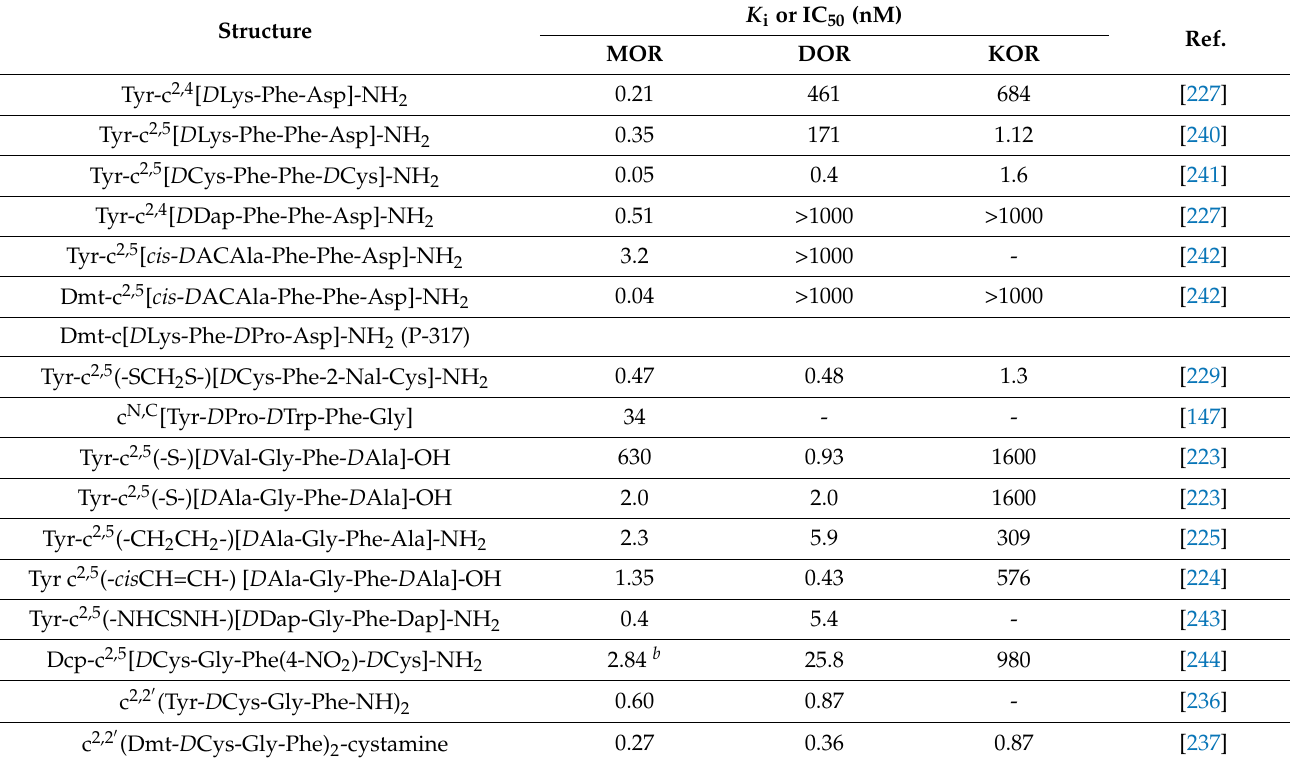
Table 3. Binding affinities of potent cyclic opioid peptidomimetics at MOR, DOR, and KOR a .